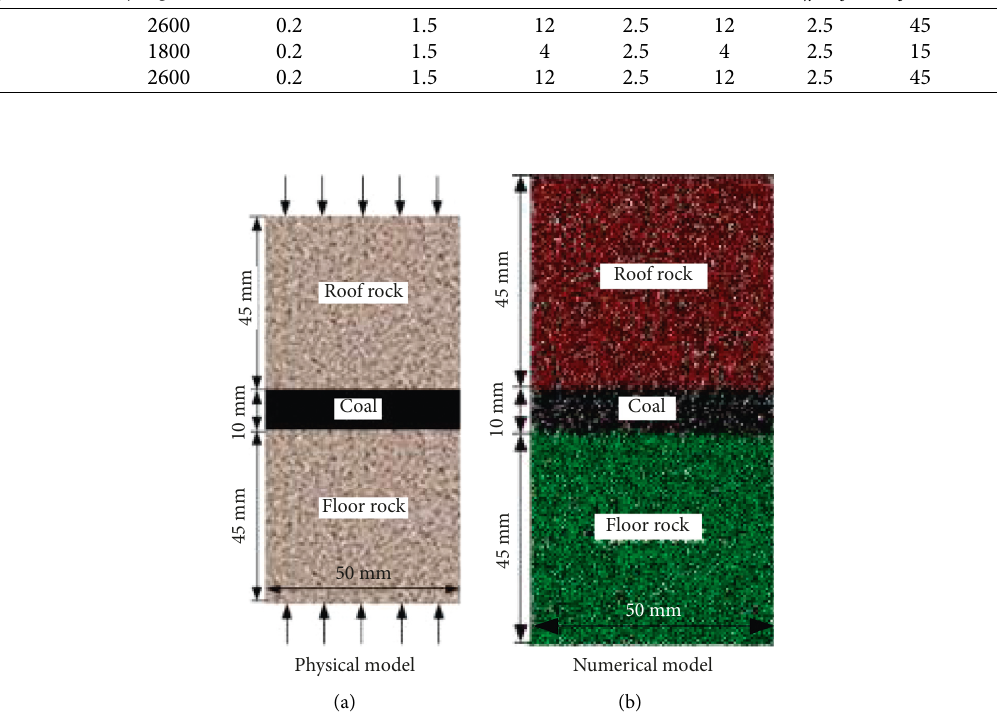
Figure 1: Physical and numerical model of the coal-rock combined sample. (a) Physical model. (b) Numerical model.